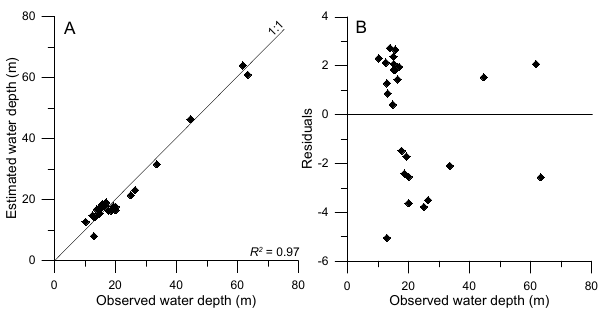
Fig. 7. Observed water depths versus estimated water depths by the WA-PLS transfer function in the surface samples (A) and their residuals (B)